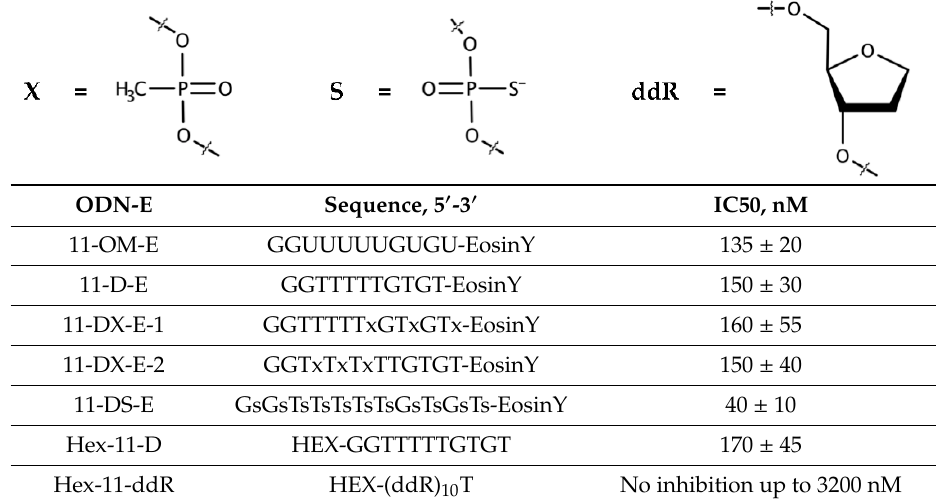
Table 1. Modifications of the oligonucleotide structure and their effects on the inhibition of the Ku70/IN complex formation.